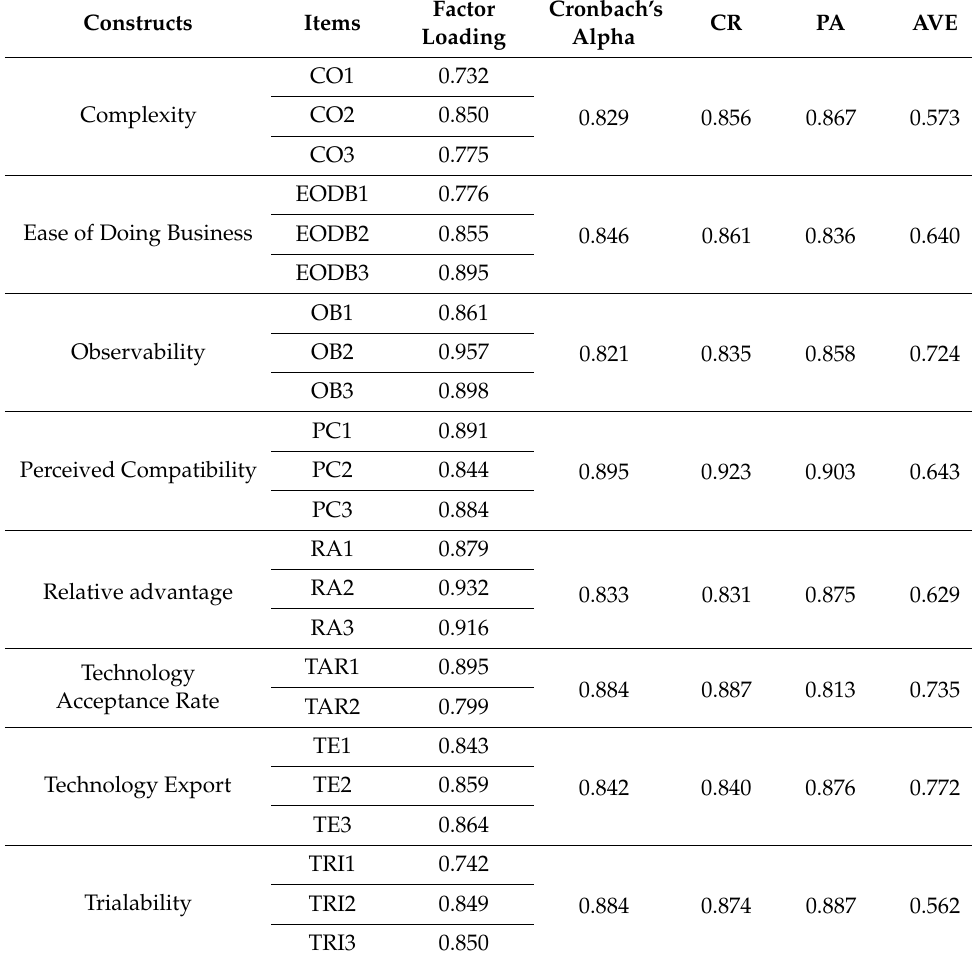
Table 5. Convergent validity results which assures acceptable values (Factor loading, Cronbach’s alpha, composite reliability, Dijkstra–Henseler’s rho ≥ 0.70 & AVE >